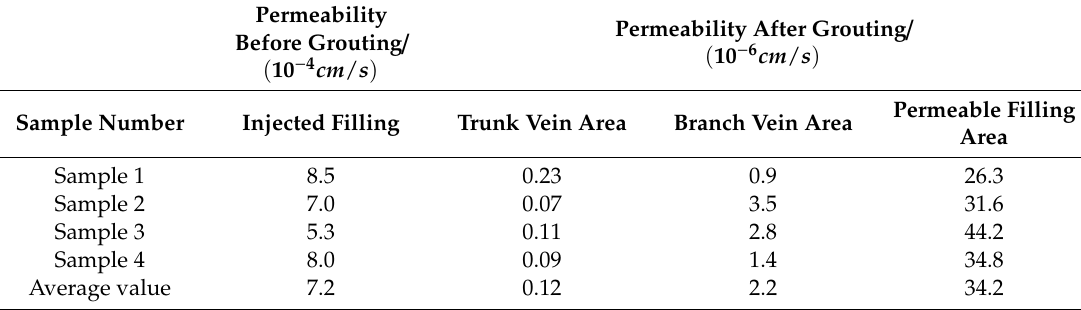
Table 4. Comparison of permeability coe ffi cient of soil before and after